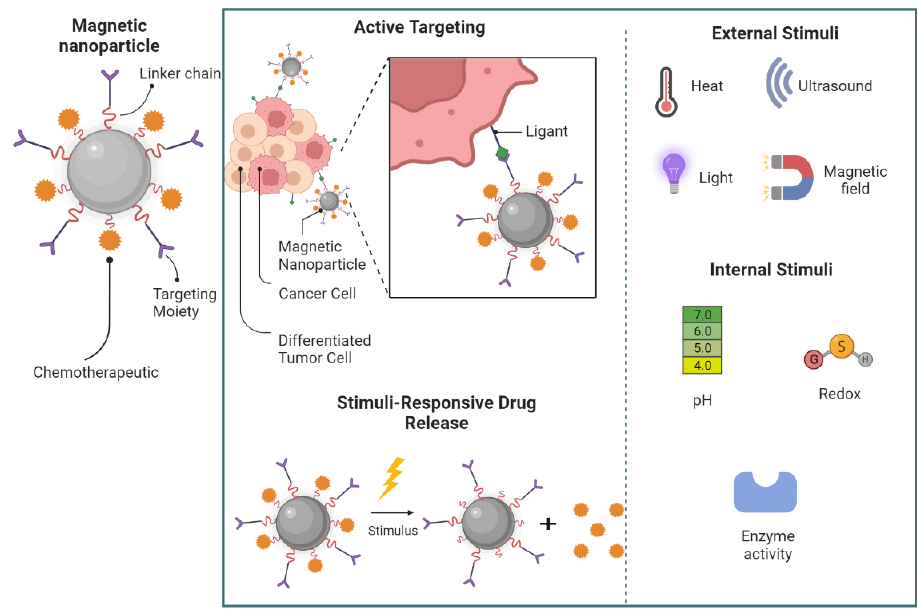
Figure 3. Illustration of active targeting of MNPs and the stimulus that can influence the heat-activated drug release.